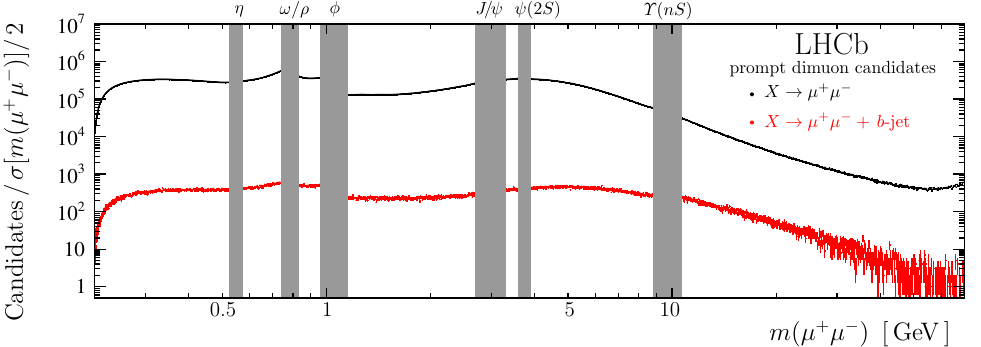
Figure 1 . Prompt dimuon mass spectra showing the (black) inclusive and (red) X + b candidates with all (cid:12)ducial and selection requirements applied. The grey boxes show the regions vetoed due to large contributions from QCD resonances.